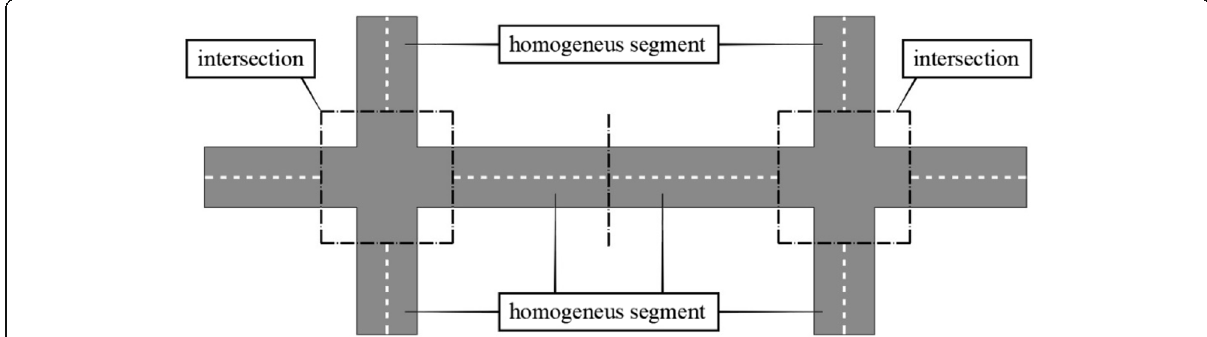
Fig. 2 Division of the road network into sites: intersections and homogeneous road